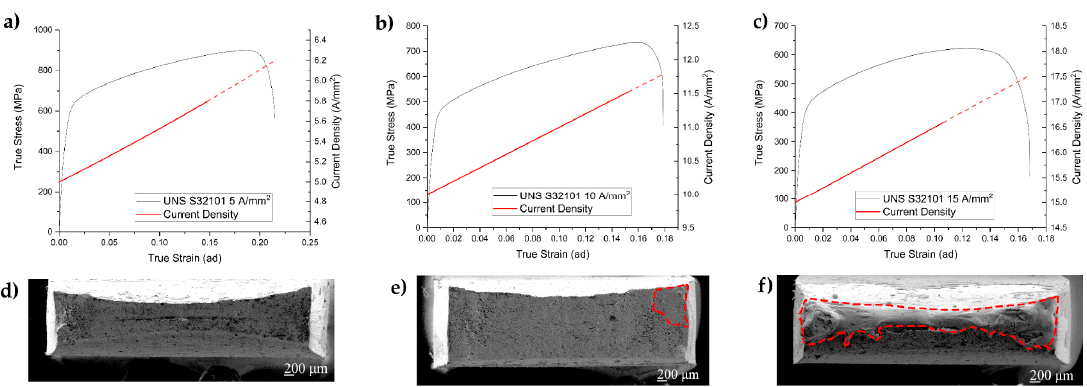
Figure 6. Current density evolution during the tensile test superimposed on the flow stress curve of the UNS S32101 and corresponding fractographies: ( a , d ) 5 A/mm 2 ; ( b , e ) 10 A/mm 2 ; and ( c , f ) 15 A/mm 2.